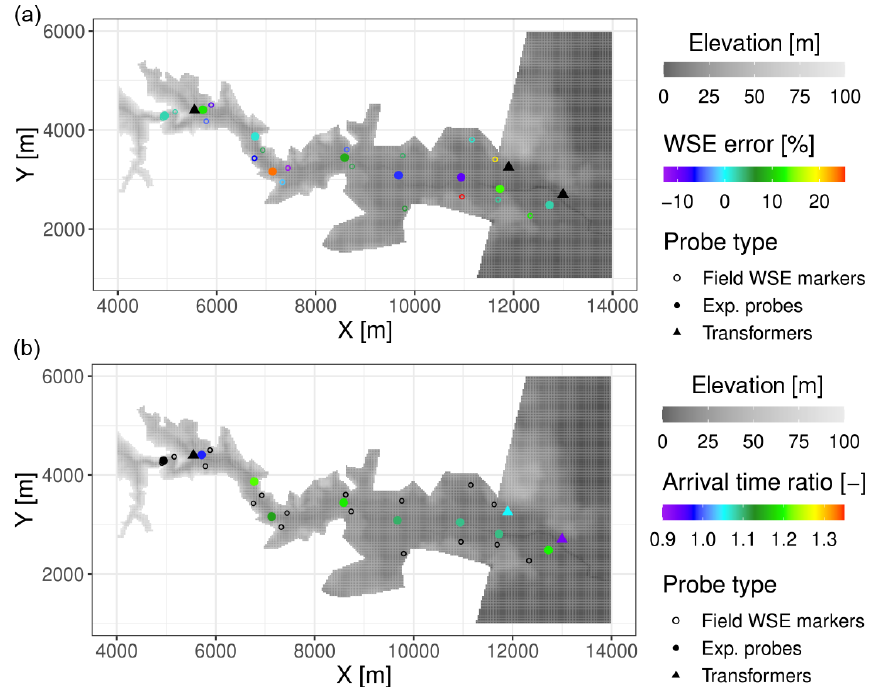
Figure 15. Geolocated relative WSE error (a) and ratio of arrival time (b) for the Malpasset dam break test case with δx =